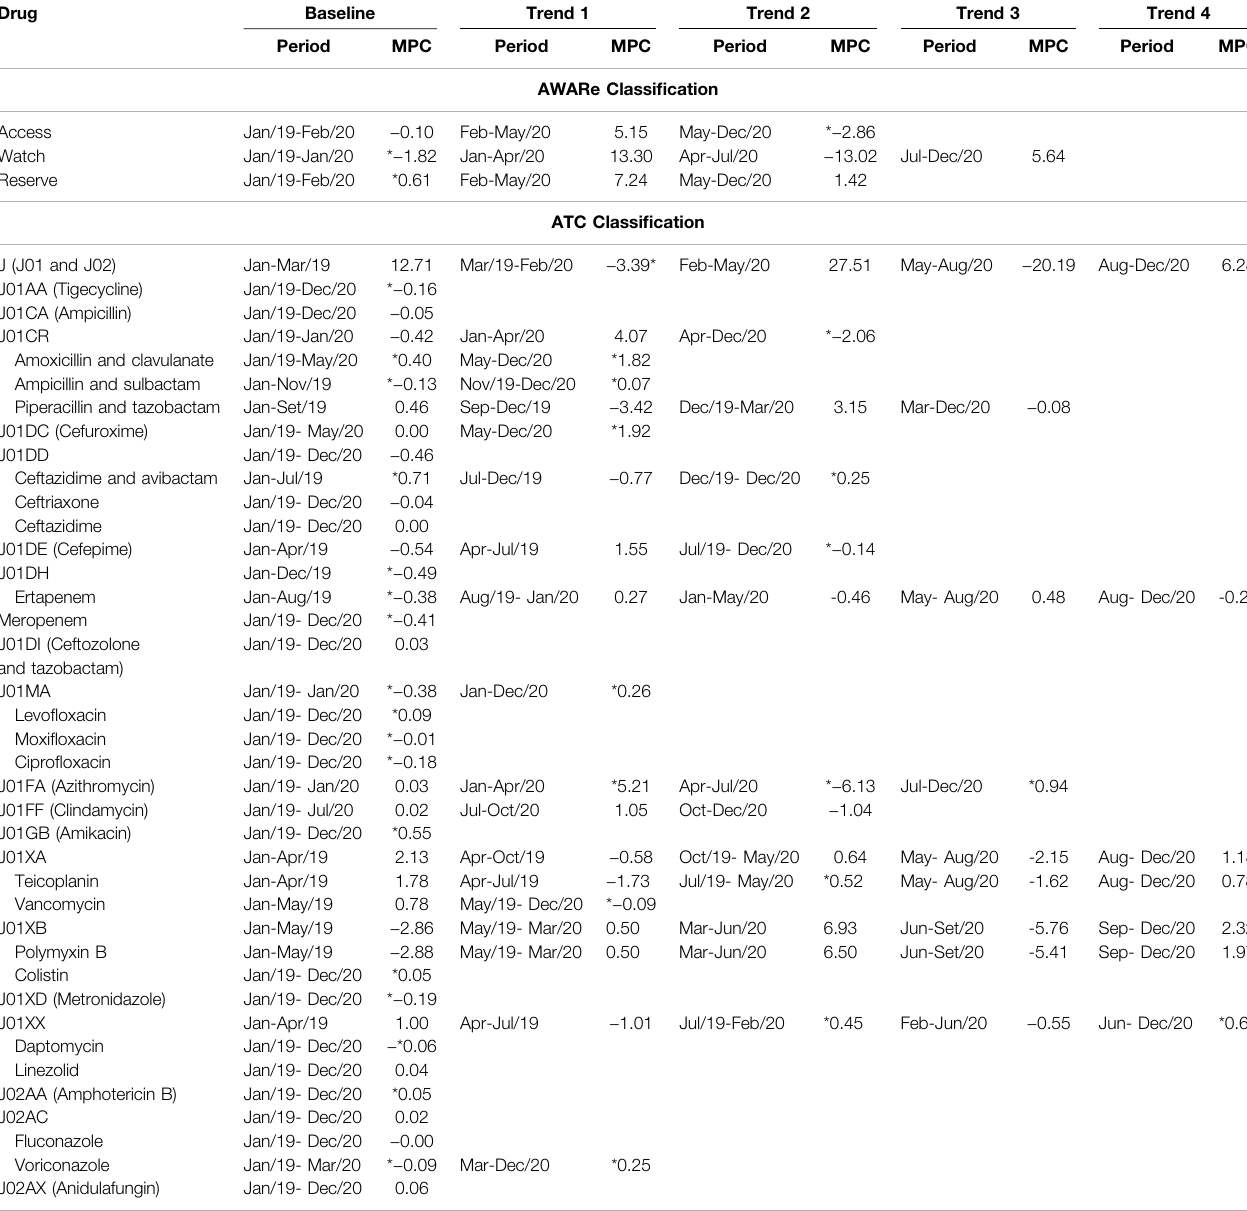
TABLE 3 | Analysis of the consumption of antimicrobials for systemic use from January 2019 and 2020 by Joinpoint regression (Rio de Janeiro, Brazil).